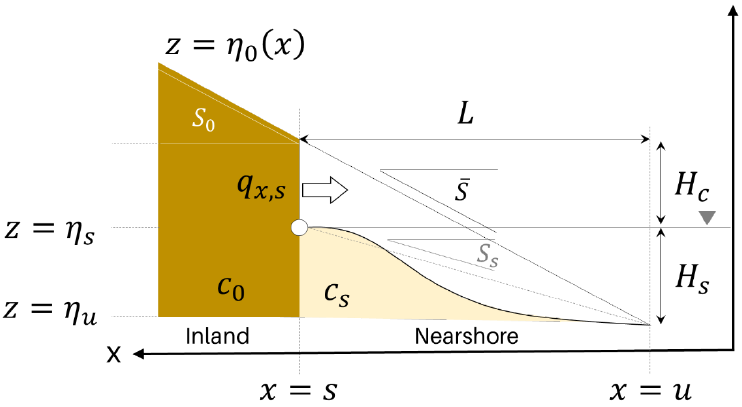
Figure 3. Idealized geometry and mass balance on a steep coast. Nearshore geometry is fixed but cliff height H c can vary in time. Shoreline s located at cliff toe. Beach top elevation η s rises with sea level z sea , maintaining a fixed beach relief. Cliff erosion produces sediment flux q s , which fuels nearshore aggradation. Sand fraction c 0 of cliff deposits may differ from nearshore sand fraction c s . (Figure adapted by authors from [7] .)